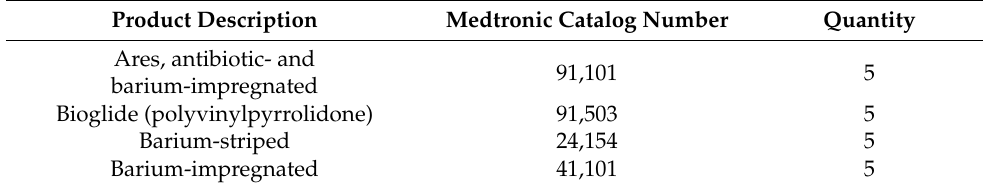
Table 1. Ventricular Catheters used in the study.